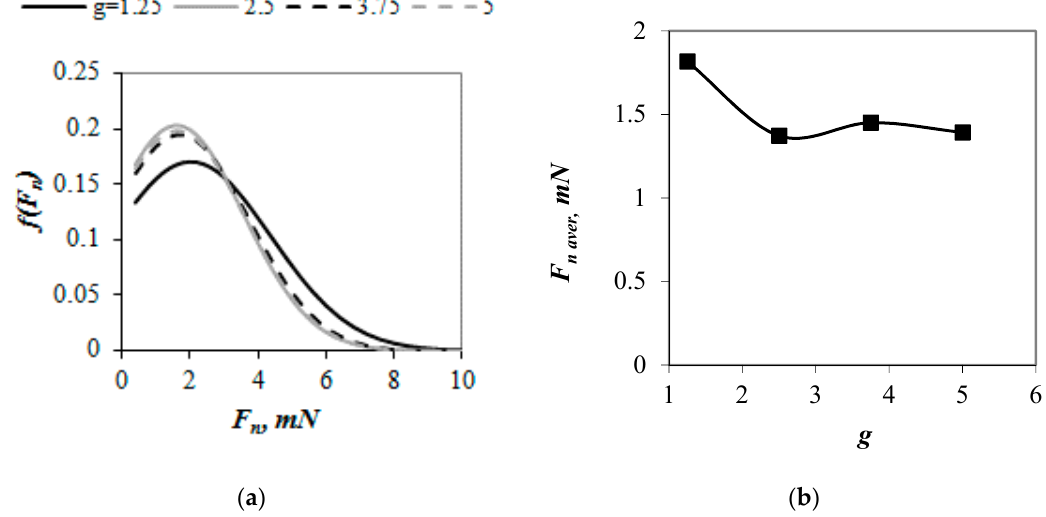
Figure 8. Average normal contact forces ( a ) and probability density functions of normal contact forces ( b ) in compressed mixtures with PSD uniform by number of spheres and various values of g.